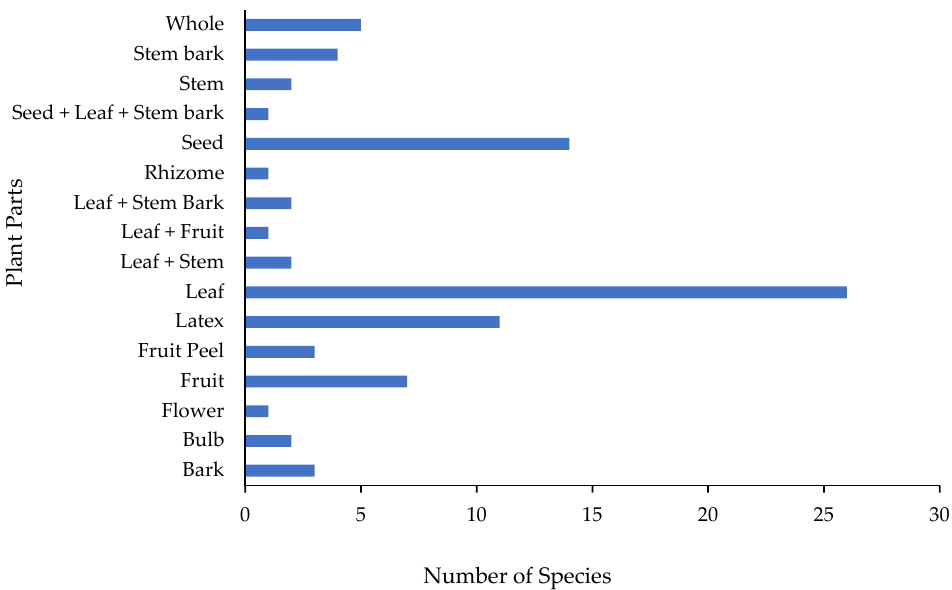
Figure 3. Plant parts used as sources of pesticide and the frequency of occurrence. Table 3. Method of Administration, Cultivation Status, Availability, and Status of Usage of Pesticidal Ethnobotanical Plants in Plateau State.